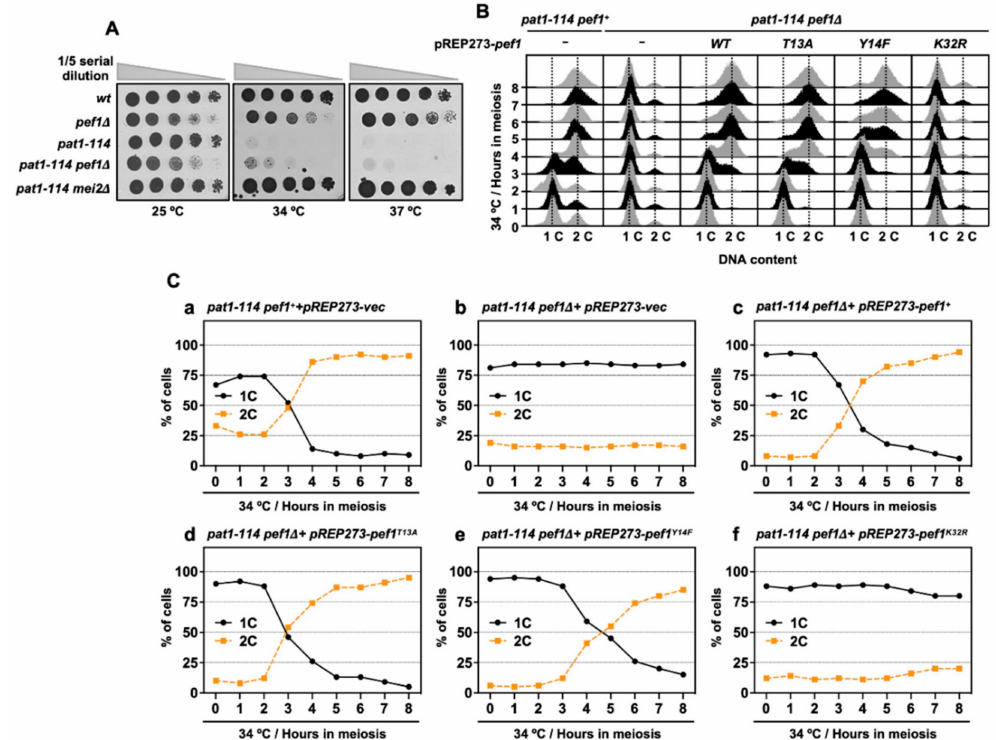
Figure 3. pef1 deletion blocks pre-meiotic DNA replication. ( A ) wt (L972), pef1 ∆ (MS009), pat1-114 (FY7052), pat1-114 pef1 ∆ (MS030) and pat1-114 mei2 ∆ (AN0579) haploid cells were precultured in EMM liquid medium. Cultures serially diluted five times were spotted on the EMM agar medium and incubated at the indicated temperatures for 3–5 days. ( B , C ) pat1-114 pef1 + (AN0353) or pat1-114 pef1 ∆ (MS254) cells were transformed with pREP273-empty vector (Ca, Cb), pREP273- pef1 + (Cc), pREP273- pef1 T13A (Cd), pREP273- pef1 Y14F (Ce)or pREP273- pef1 K32R (Cf). Synchronous meiosis was induced by temperature shifting. The cells were fixed at the indicated times and stained with propidium iodate (PI). DNA contents were measured by flow cytometry analysis ( B ). Percentages of cells with an unreplicated DNA content (1C, black solid line) and replicated DNA content (2C, orange broken line) after the induction of synchronous meiosis. Results are expressed as averages from two independent experiments ( C